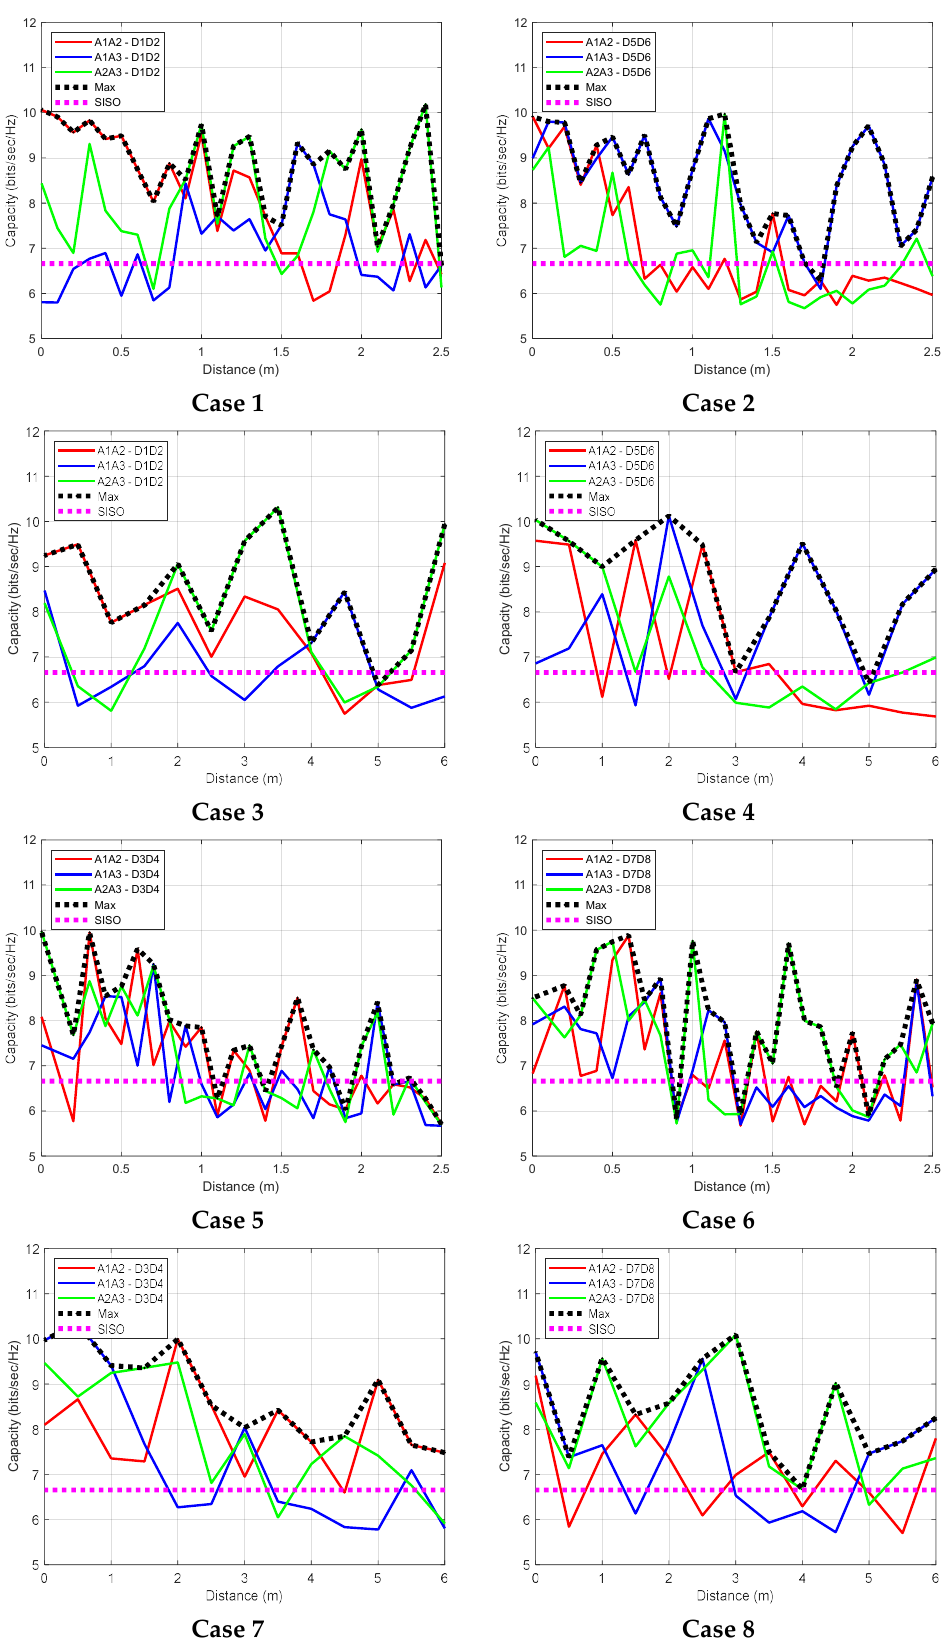
Figure 15. Capacity calculated for various MIMO settings.